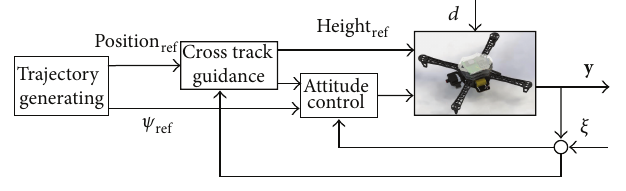
Figure 10: Trajectory tracking strategy.